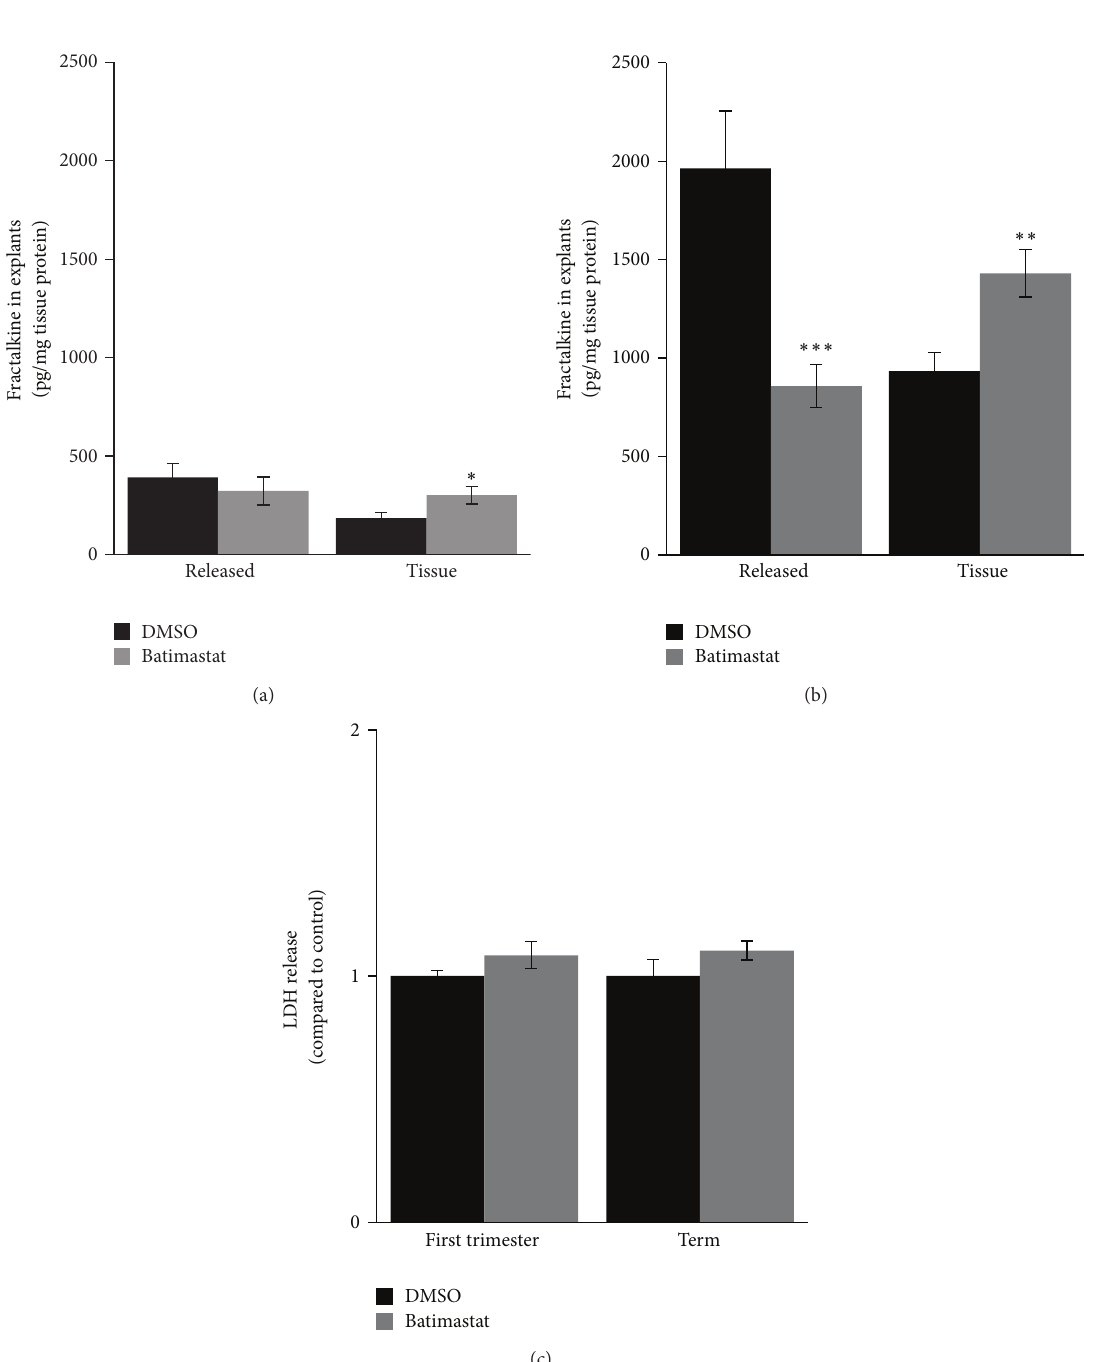
Figure 5: Effect of Batimastat on therelease ofsoluble fractalkine inplacental explants. In firsttrimesterplacental explants Batimastat (10 𝜇 M) slightly but not significantly decreased the release of soluble fractalkine, whereas at the same time tissue associated fractalkine increased, compared to control (DMSO, 0.1%) after 5-day culture (a). Incubation of term placental explants with Batimastat (10 𝜇 M) led to a considerable decline in fractalkine release and was accompanied with an increase of the tissue associated fractalkine fraction after 5-day culture (b). Analysis of culture media from first trimester and term placental explants showed slight but not significant increase of released LDH activity in presence of Batimastat (10 𝜇 M) compared to control after 5-day culture (c). Data in (a) are presented as mean ± SEM from seven different explant experiments performed in triplicate. Data in (b) and (c) are presented as mean ± SEM from three different explant experiments performed in triplicate. ∗ 𝑃 ≤ 0.05 , ∗∗ 𝑃 ≤ 0.01 , ∗∗∗ 𝑃 ≤ 0.001